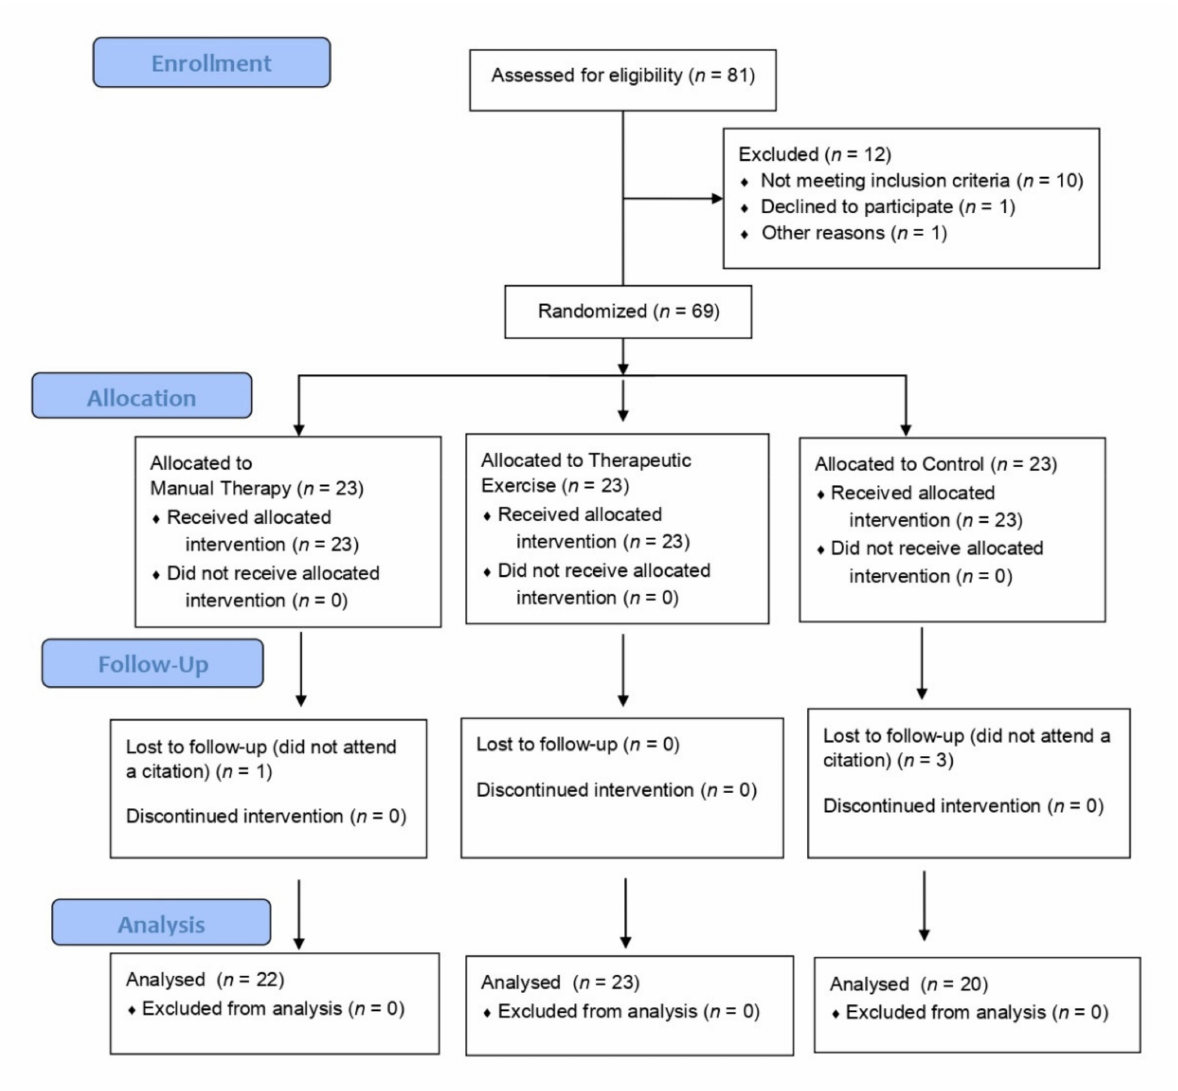
Figure 4. CONSORT Flows